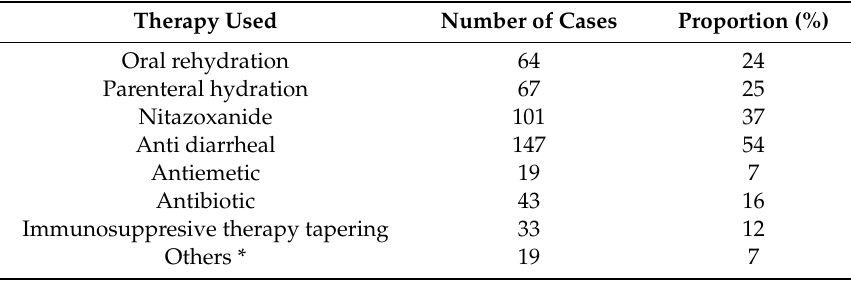
Table 4. Cryptosporidiosis treatment in reported cases.